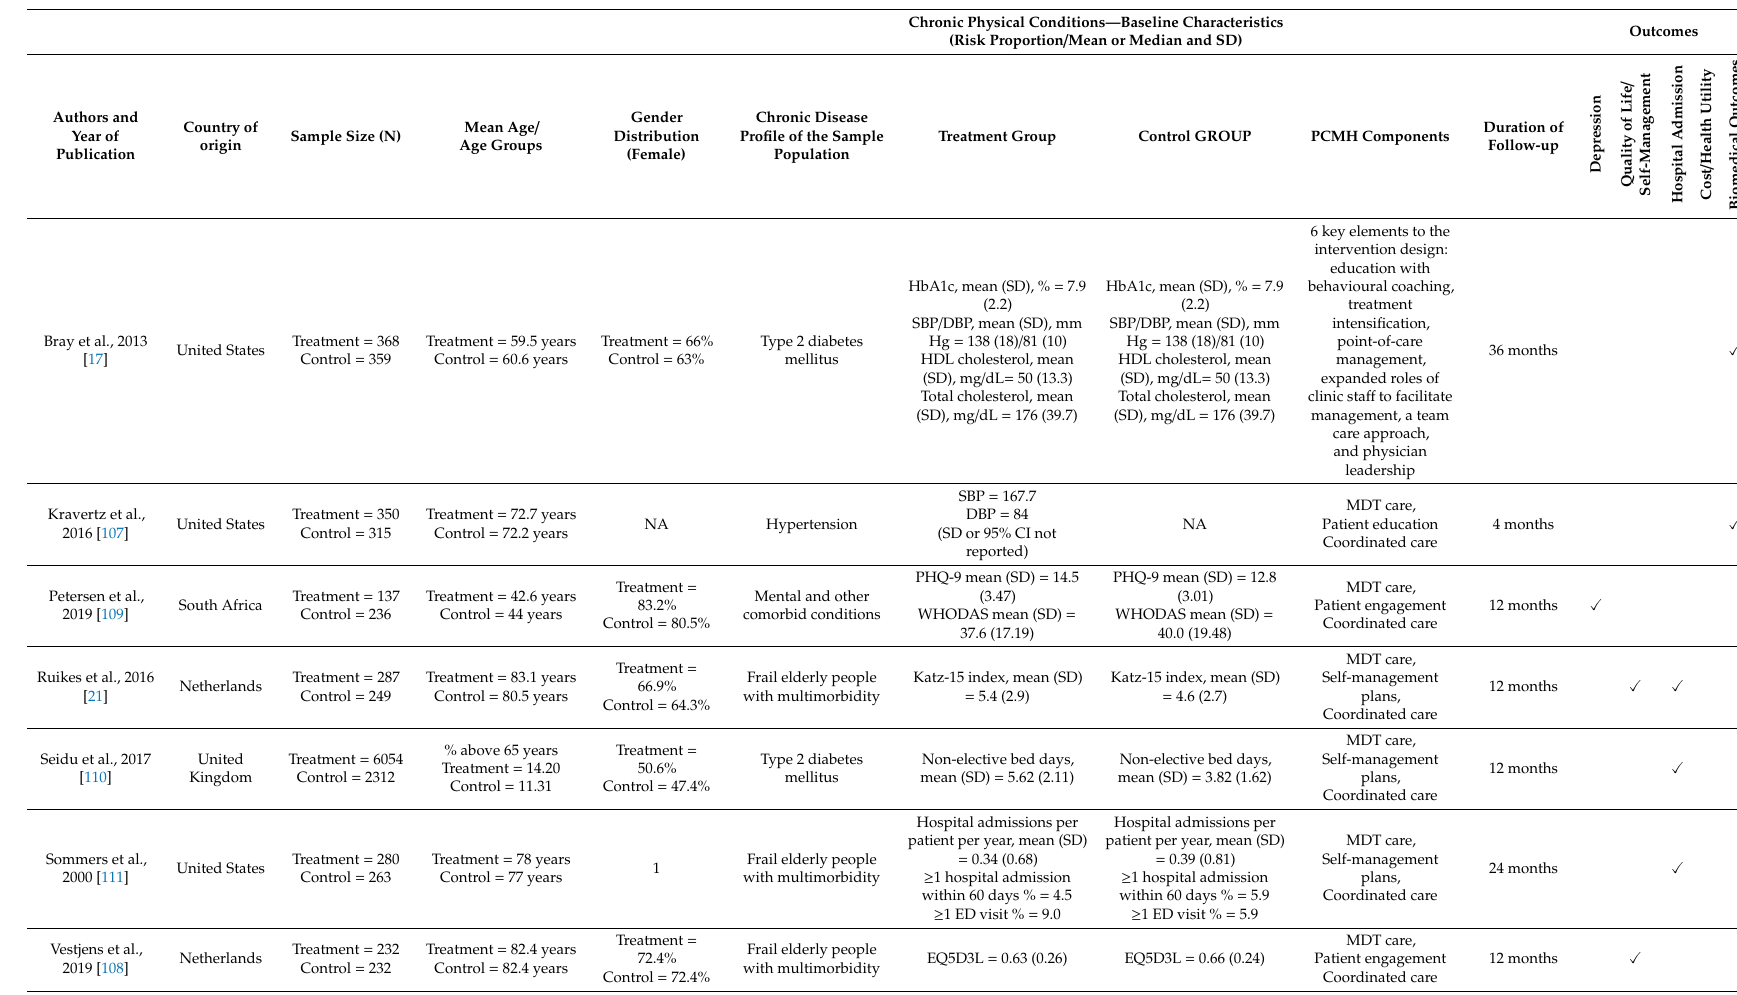
Table A4. Characteristics of non-randomised controlled trials